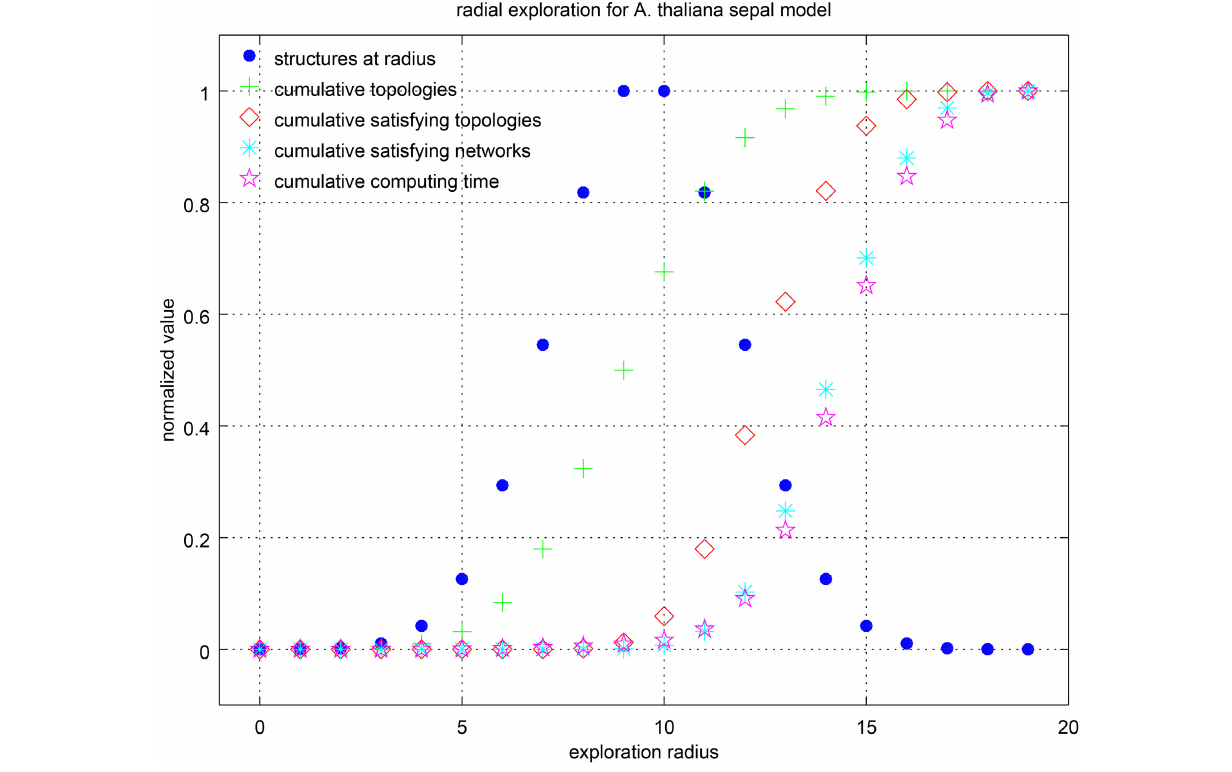
h , where h is the number of hypotheses and r the radius. It can be seen that the computing time is highly r (cid:0) (cid:1)